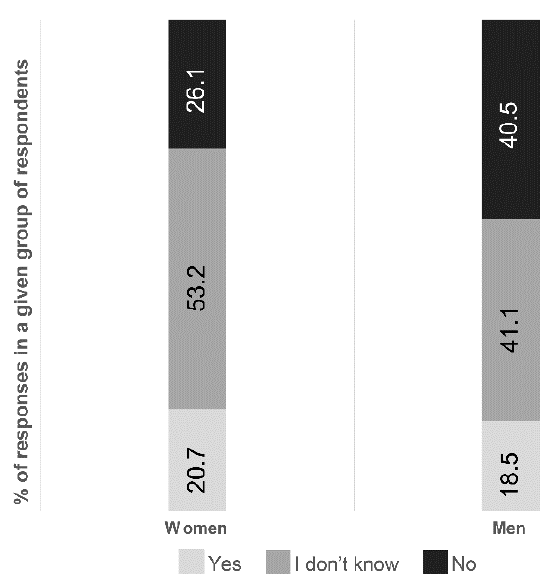
Figure 7. Willingness to change one’s own apartment for a nursing home, depending on gender.